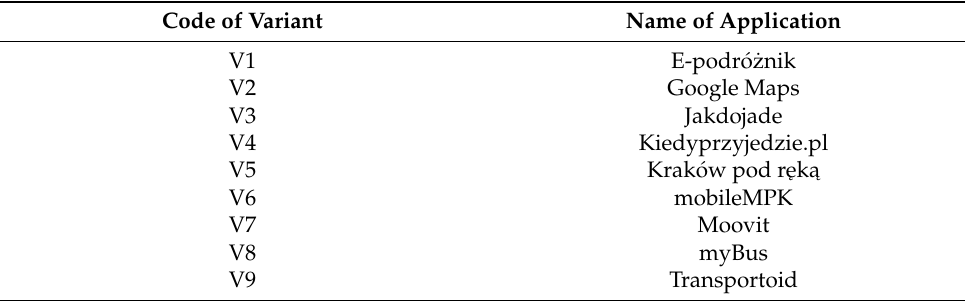
Table 1. List of assessed applications with the adopted labels.